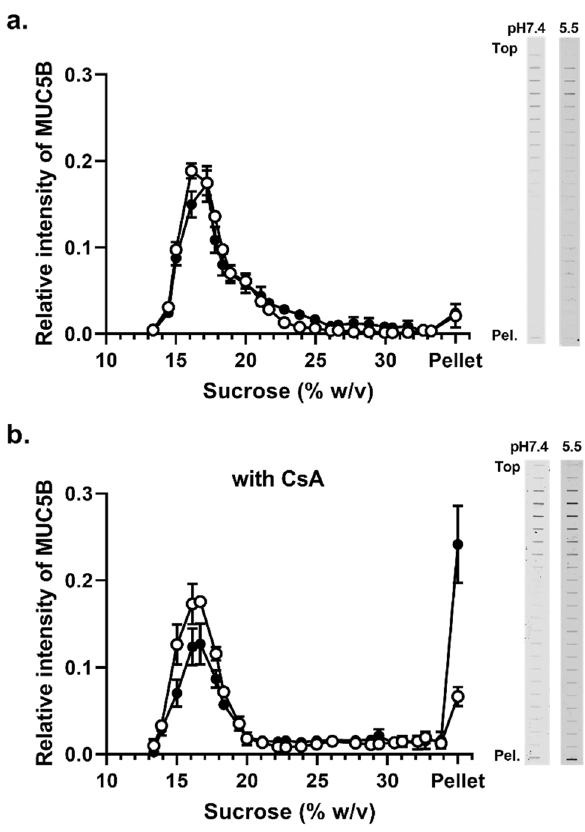
Figure 6. The effect of pH on the aggregation of purified MUC5B in the presence of CsA. Rate-zonal centrifugation on 10–35% (w/v) sucrose gradients of purified MUC5B at pH 7.4 (white) and pH 5.5 (black) in PBS ( a ) or in PBS containing 200 μM CsA ( b ). MUC5B was immunodetected in the gradient fractions using the EUMUC5B antibody after slot blotting. The results are presented as the mean ± s.e.m. (n = 3–6) from 3 independent experiments. The blots were cropped and full-length blots are presented in Supplementary Fig.